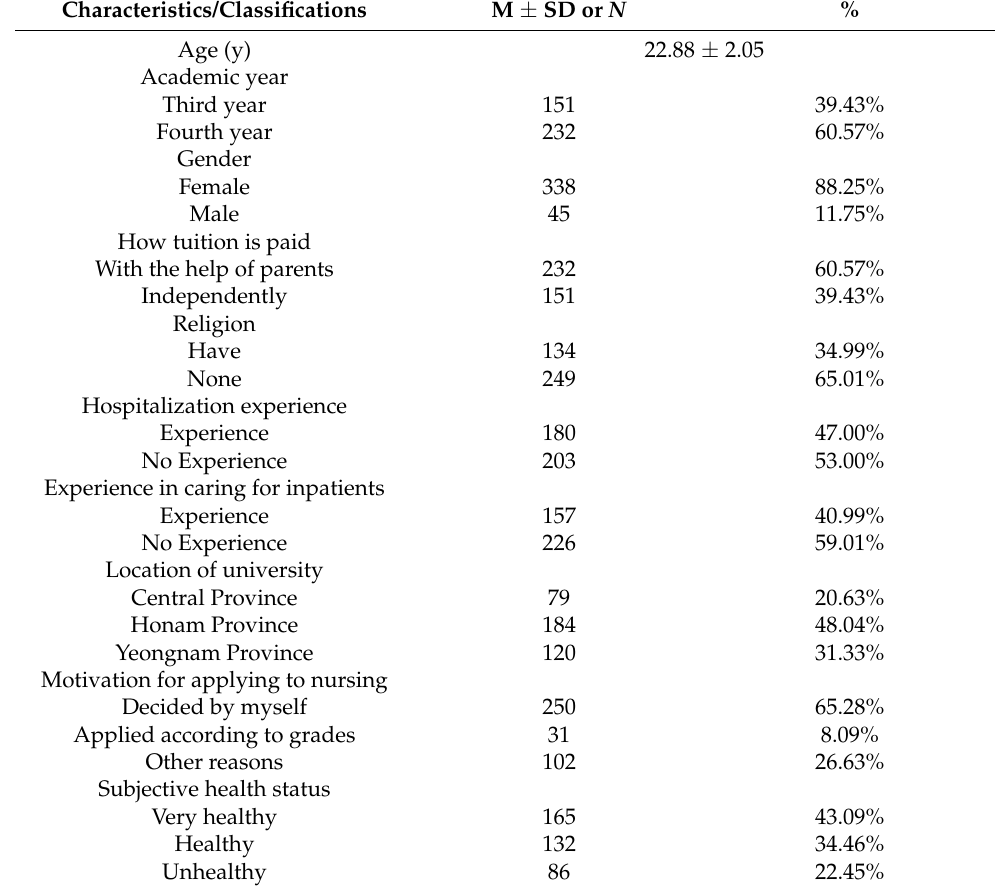
Table 1. Characteristics of participants ( N = 383).